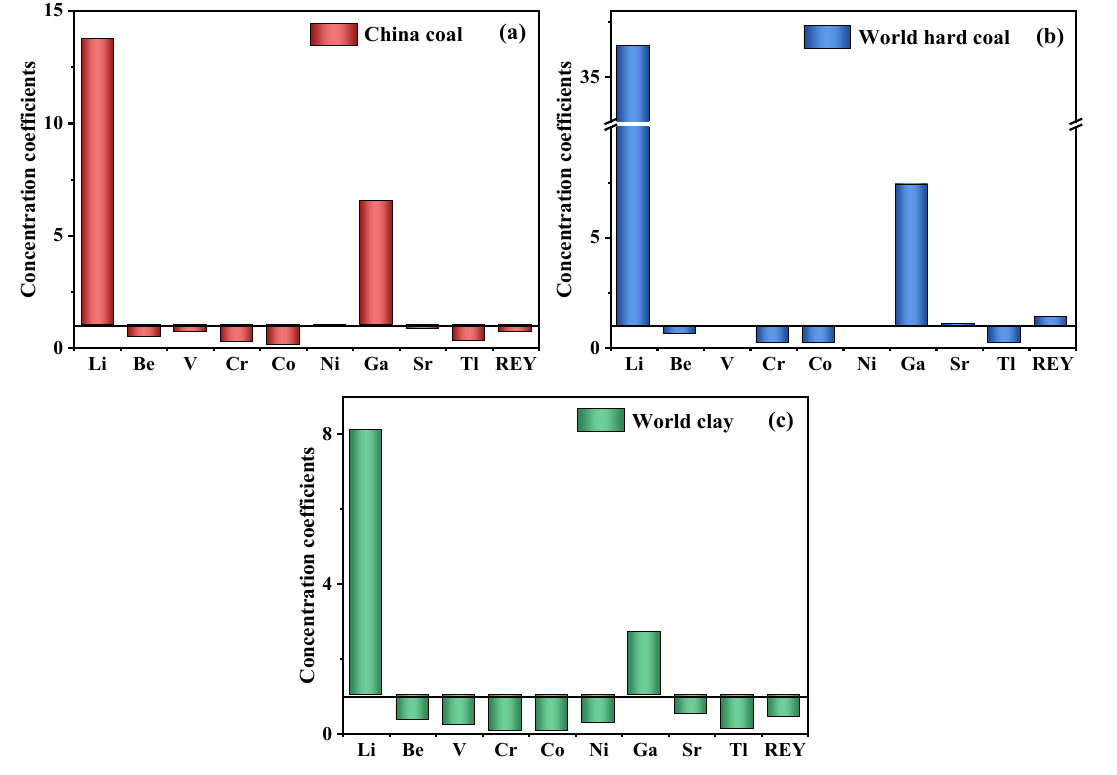
Figure 3. Concentration coefficients (CC), the ratios of elemental content in the studied coal gangue to an average of the corresponding element in China coal ( a ), world hard coal ( b ), and world clay ( c ), of critical elements in coal gangue. Data for China coal, world hard coal, and world clay are from Dai et al. [53], Ketris et al. [52], and Grigoriev et al. [55], respectively.